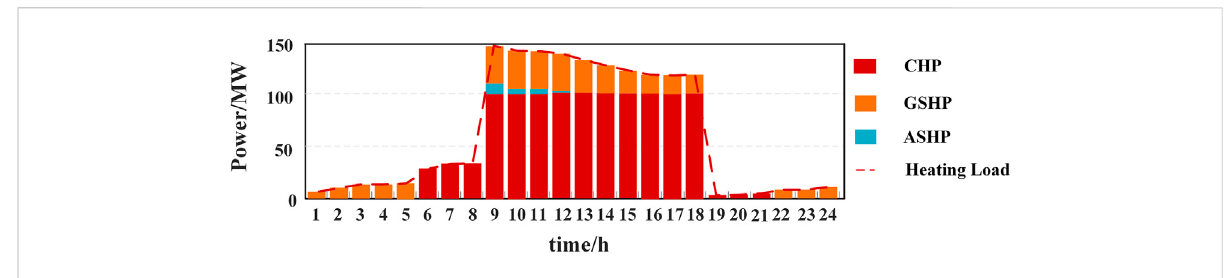
FIGURE 9 The optimal heat operation strategies in spring.